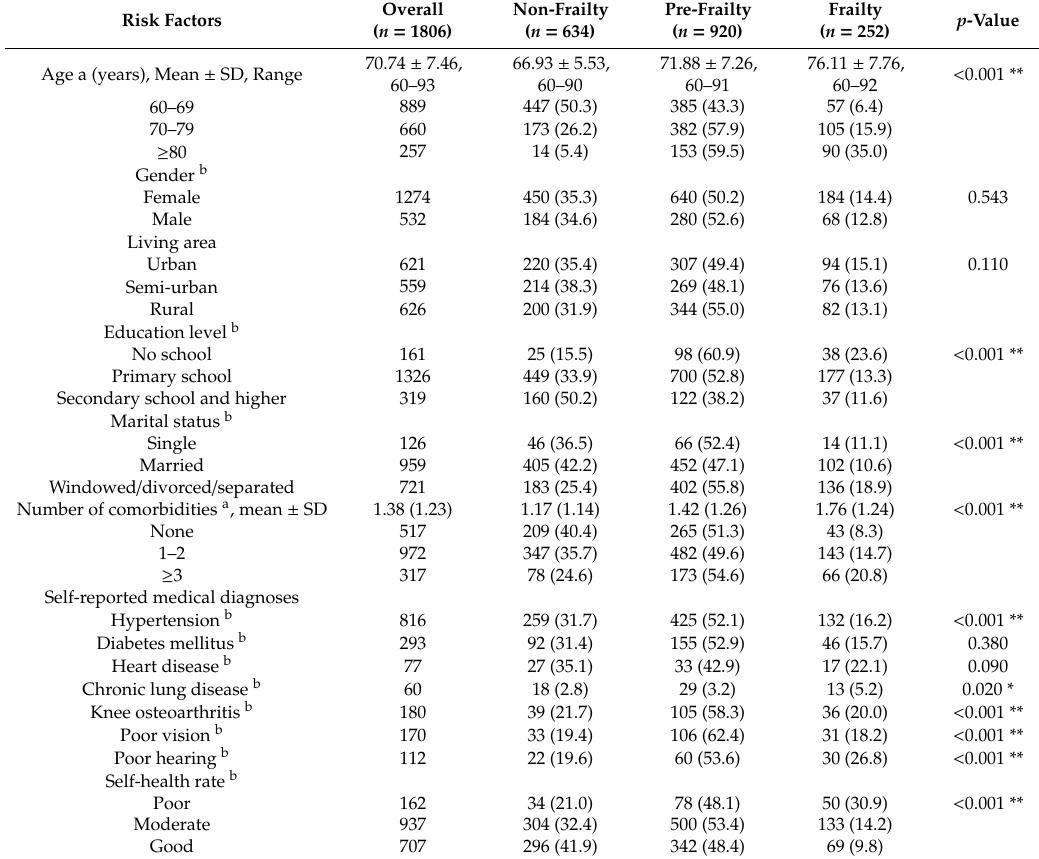
Table 2. Description of risk factors according to frailty